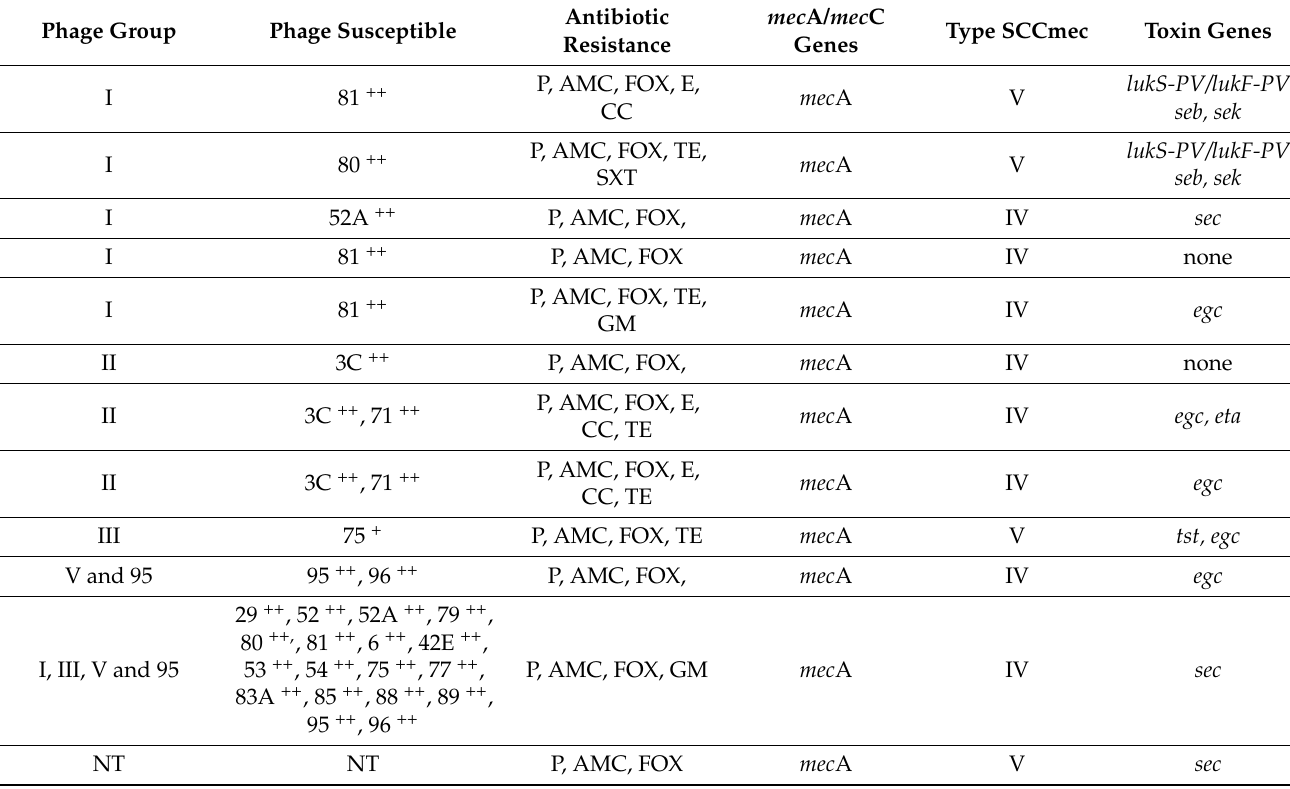
Table 1. Characteristics of methicillin-resistant oral S. aureus